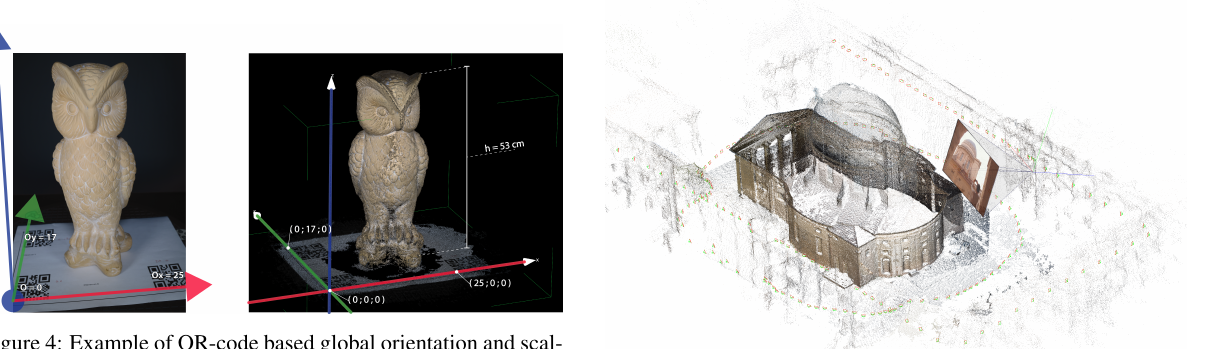
Figure 4: Example of QR-code based global orientation and scal- ing on small artefact dataset